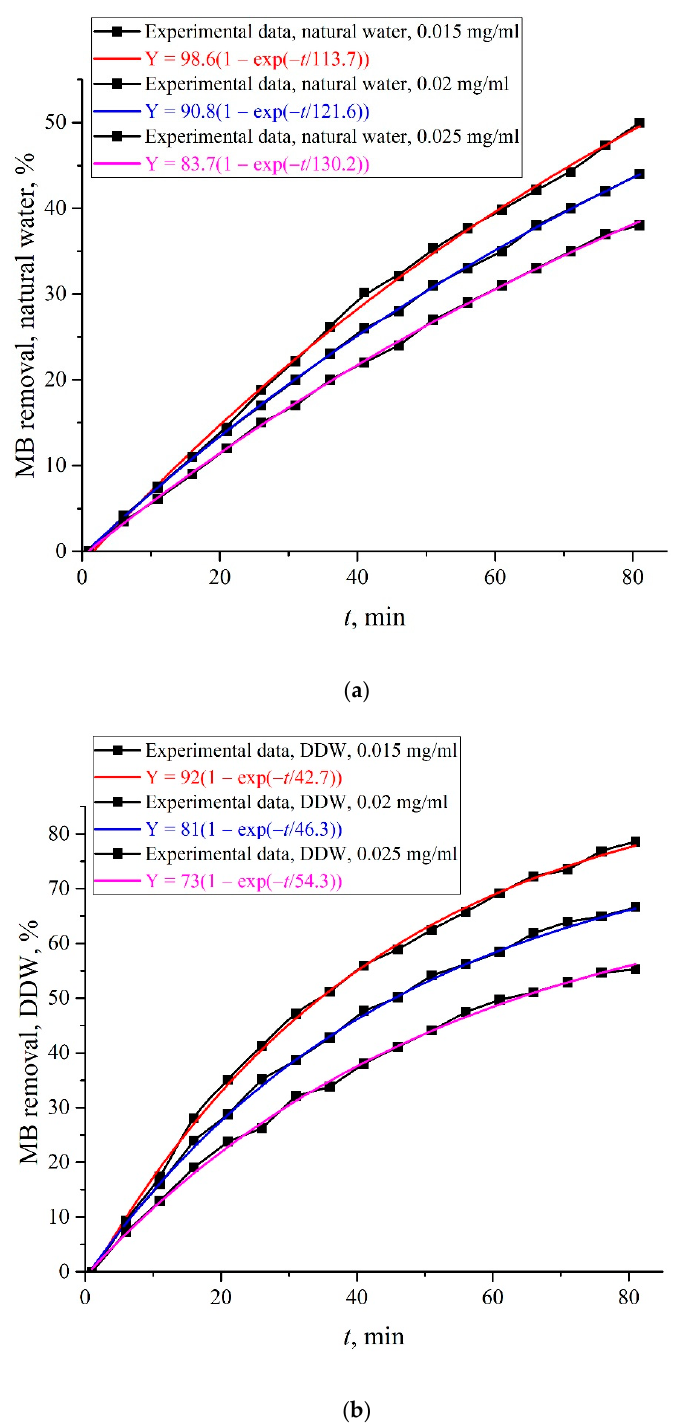
Figure 6. The dependences {[ κ ( t = 0) − κ ( t )]/ κ ( t = 0)} × 100%. Panel ( a )—the MB solution is based on natural water. Panel ( b )—the MB solution is based on DDW.